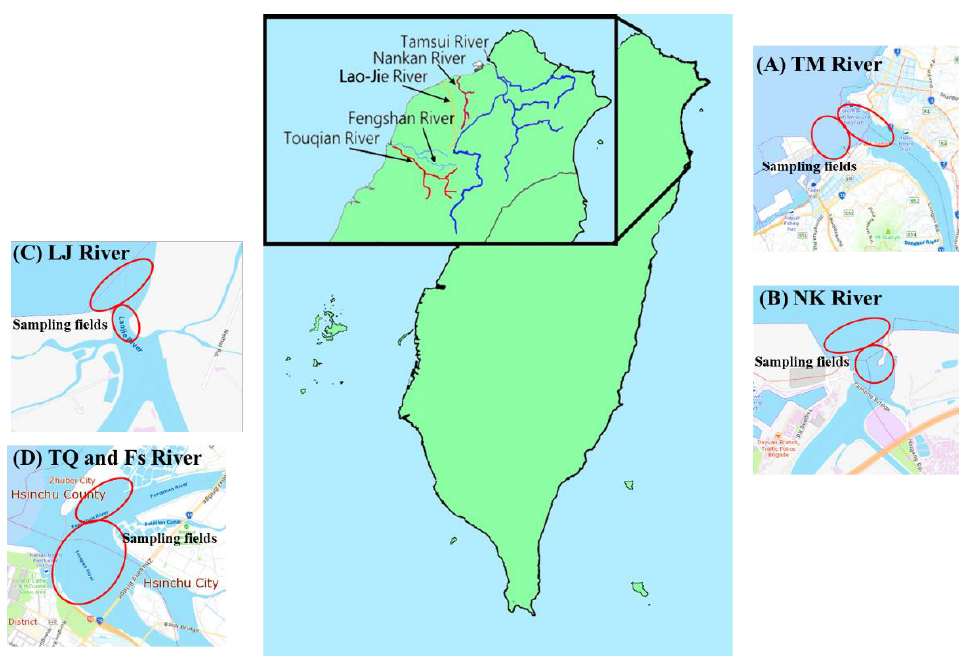
Figure 1. The fish were caught in the estuaries of five main rivers in northern Taiwan. The 130 pooled fish samples were investigated in the present study. The abbreviations of Tamsui, Nankan, Lao-Jie, Fengshan, and Touqian Estuaries are TM, NK, LJ, FS, and TQ, respectively. The sampling locations are shown as red circles in five river estuaries: ( A ) TM, ( B ) NK, ( C ) LJ, and ( D ) FS and TQ.